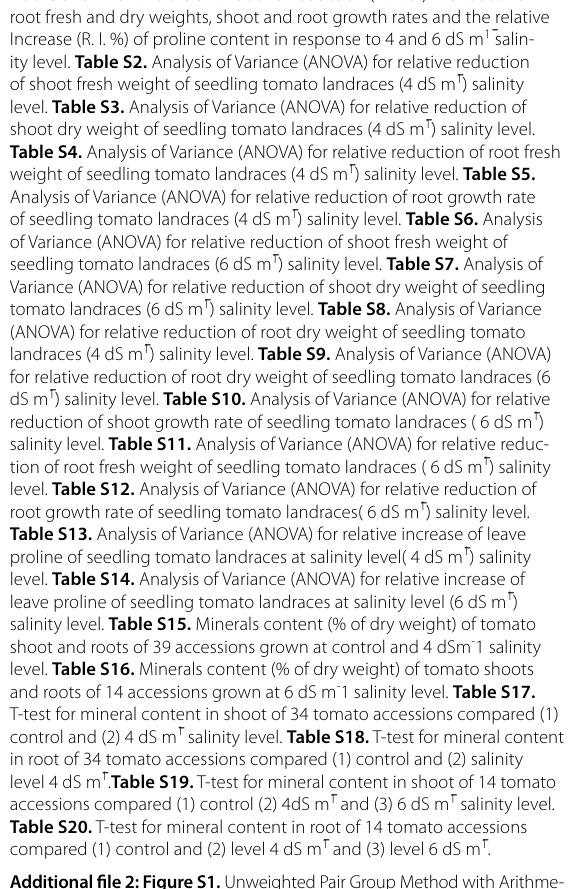
Table S13. Analysis of Variance (ANOVA) for relative increase of leave proline of seedling tomato landraces at salinity level( 4 dS m ֿ 1 ) salinity level. Table S14. Analysis of Variance (ANOVA) for relative increase of leave proline of seedling tomato landraces at salinity level (6 dS m ֿ 1 ) salinity level. Table S15. Minerals content (% of dry weight) of tomato shoot and roots of 39 accessions grown at control and 4 dSm - 1 salinity level. Table S16. Minerals content (% of dry weight) of tomato shoots and roots of 14 accessions grown at 6 dS m - 1 salinity level. Table S17. T-test for mineral content in shoot of 34 tomato accessions compared (1) control and (2) 4 dS m ֿ 1 salinity level. Table S18. T-test for mineral content